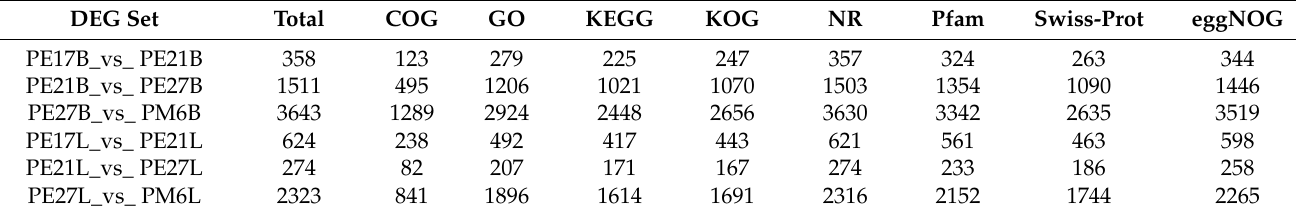
Table 5. Number of annotated differentially expressed genes (DEGs) in breast and leg muscle of Pekin